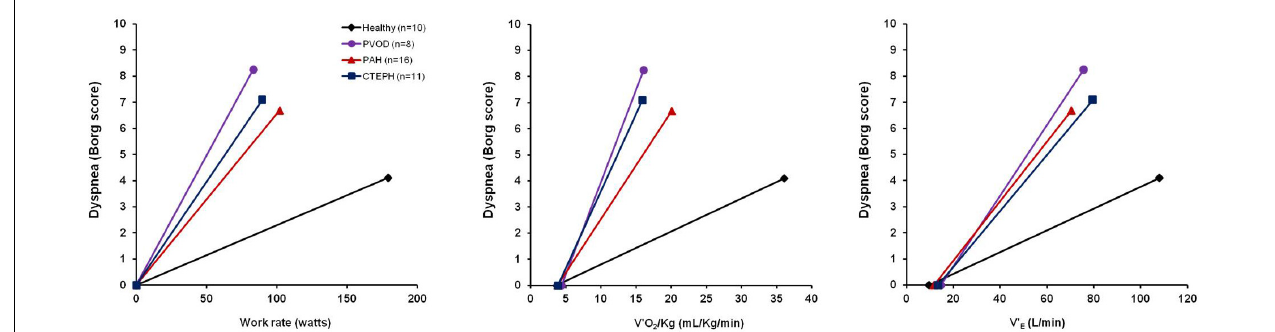
FIGURE 4 | Exertional dyspnea intensity as measured by Borg score is displayed in response to increasing work rate (left panel) , increasing oxygen consumption (V (cid:48) O 2 /Kg, mid panel ) and increasing minute ventilation (V’ E , right panel ) during symptom limited cardiopulmonary exercise testing in 10 healthy subjects (black line and rhomboid), 8 patients with pulmonary veno-occlusive disease (PVOD) (violet line and circles), 16 patients with pulmonary arterial hypertension (PAH) (red line and triangles), 11 patients with chronic thromboembolic pulmonary hypertension (CTEPH) (blue line and squares). The origin of the data provided in Figure 4 is from Laveneziana et al. (2013b, 2014a, 2015), Boucly et al. (2020) and Weatherald et al. (2020).